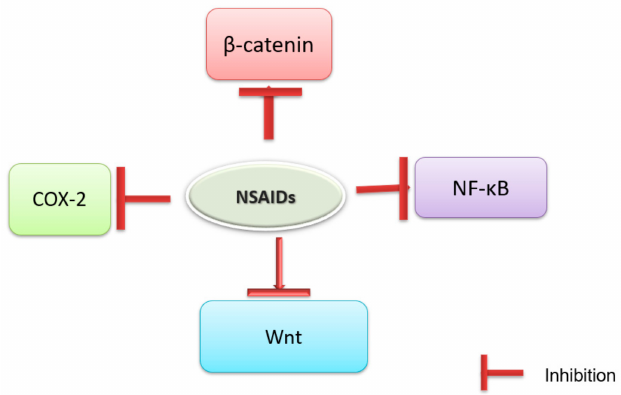
Figure 2. Molecular targets of selected non-steroidal anti-inflammatory drugs (NSAIDs) for colorectal cancer (CRC)